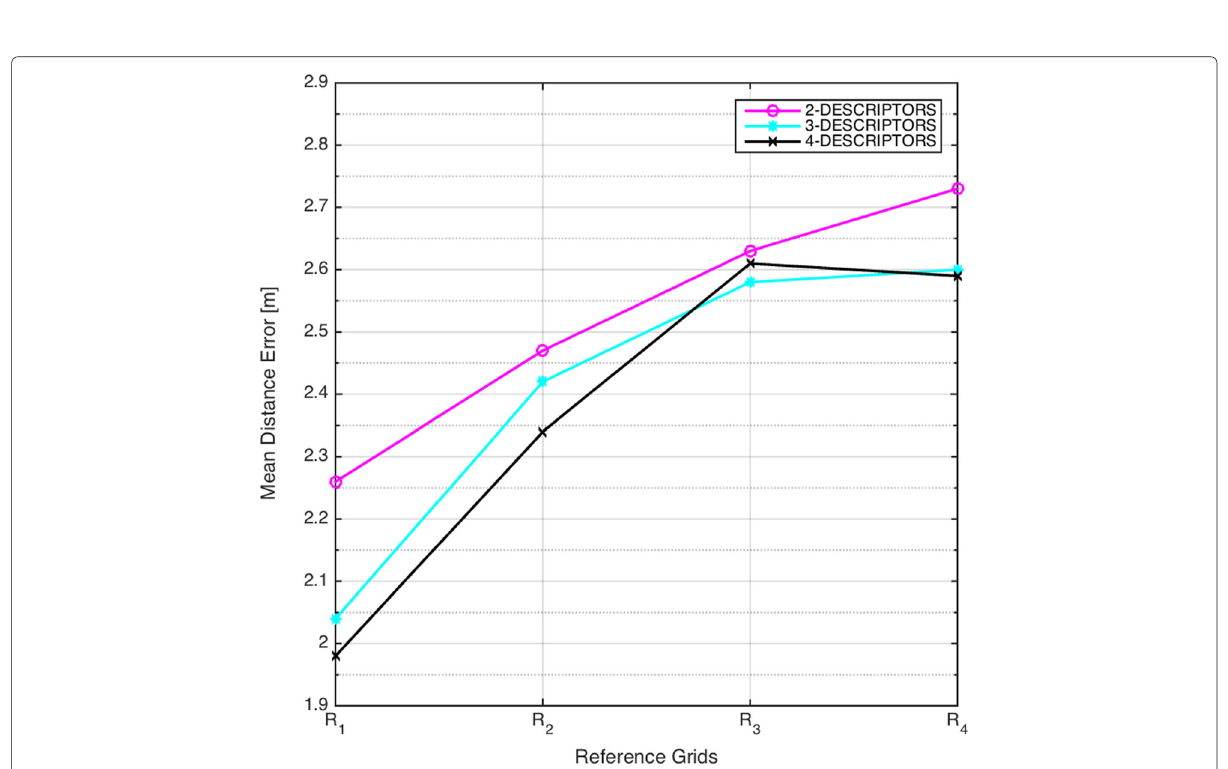
Fig. 13 Effect of reference point reduction. Mean Distance Error vs number of reference points for RSRP/CSI